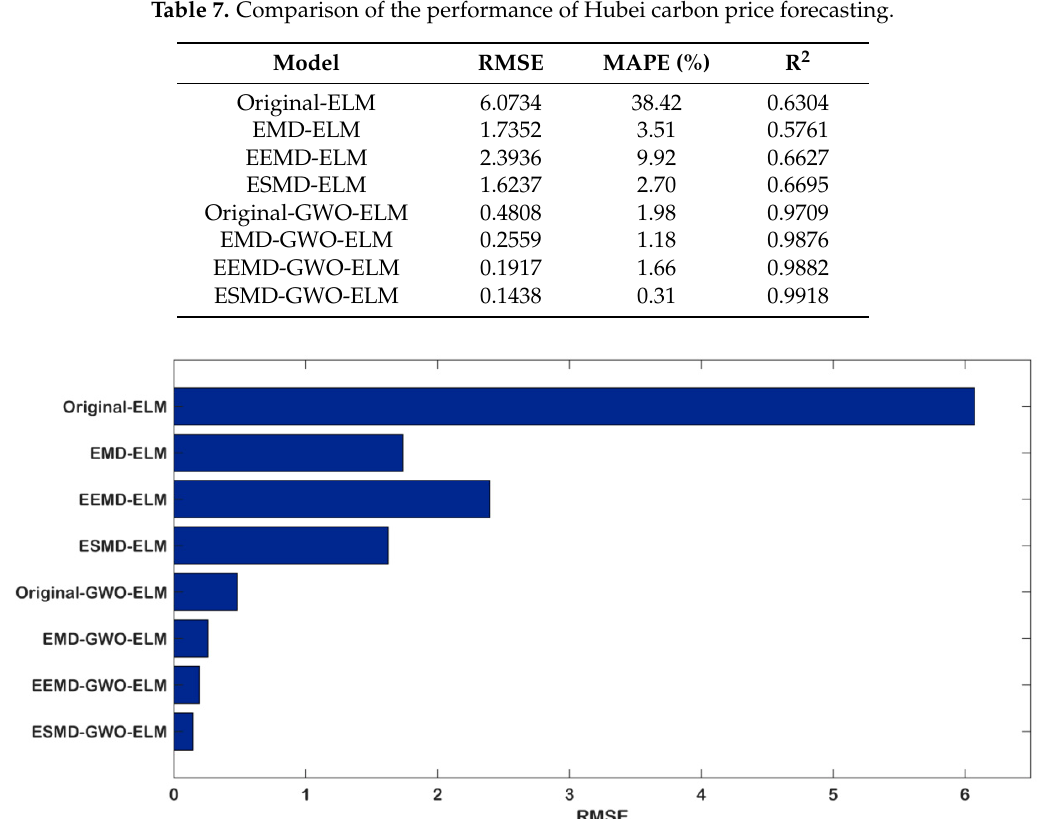
Figure 12. The values of the RMSE-parallel models.